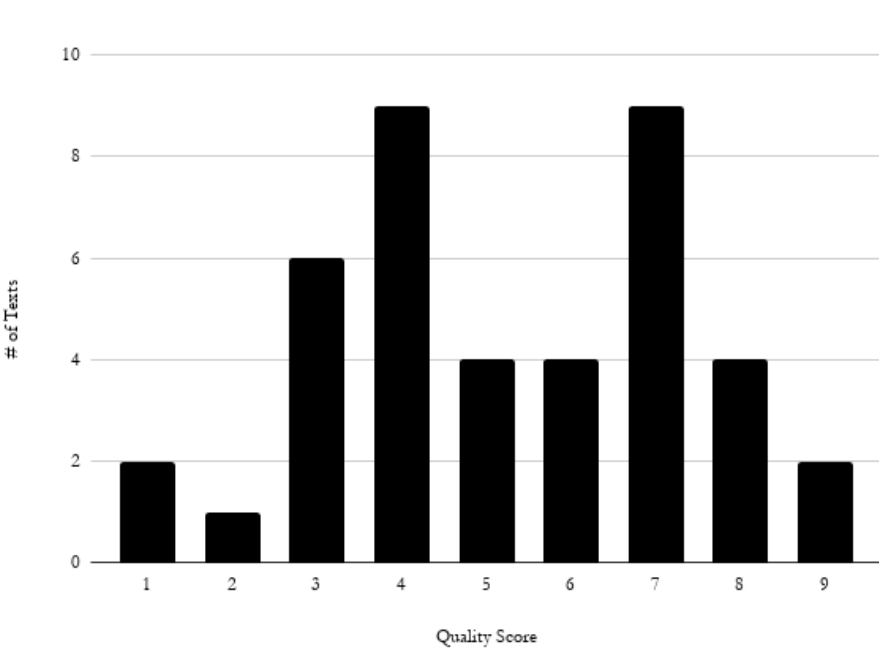
Figure 2 . Distribution of pedagogical quality scores.